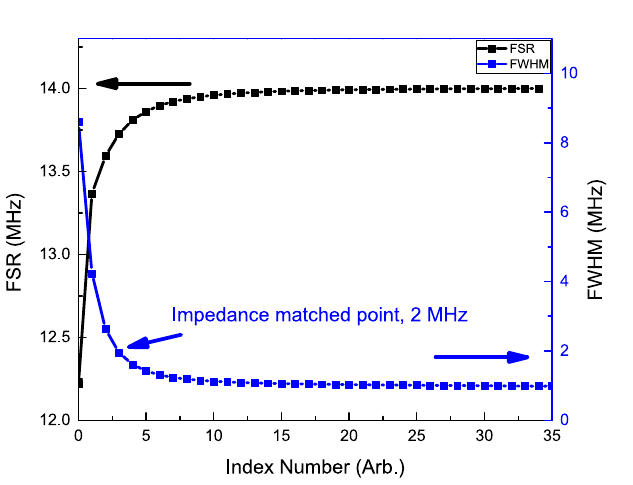
Figure 4. Theoretical linewidth (FWHM, blue line) and FSR (black line) of 7.3 m long PSFBG-F-FBG resonator, plotted versus the index